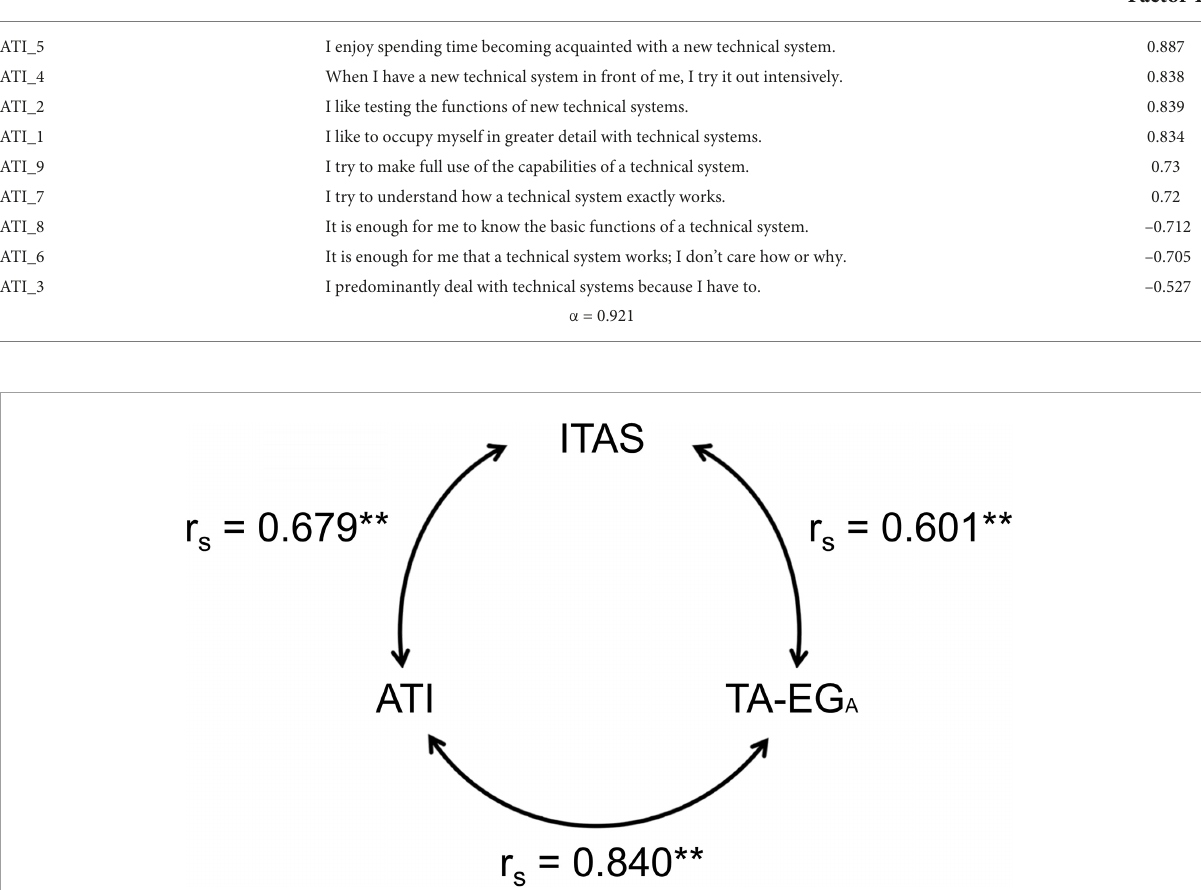
TABLE 2 Results of the principal axis factoring (PAF) with the items of the ATI and the related factor loadings.